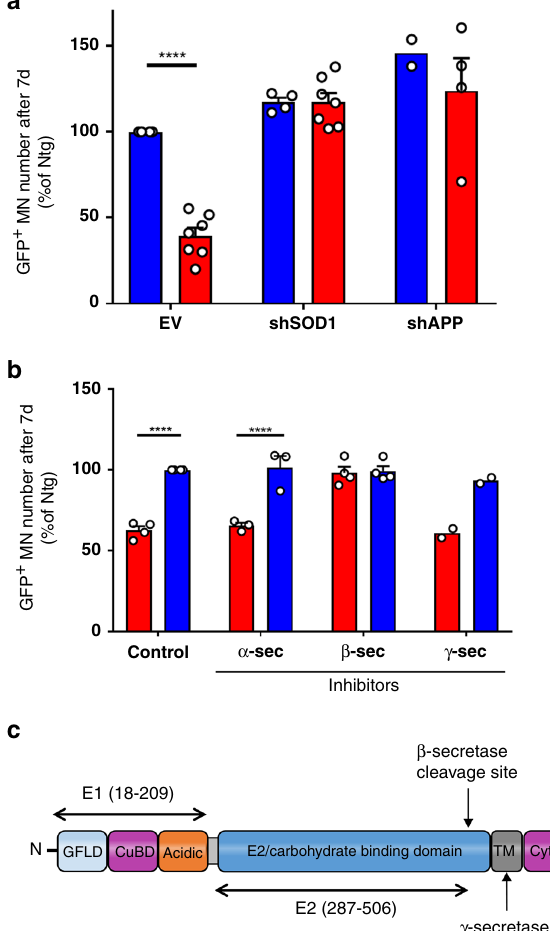
Fig. 3 mutSOD1 astrocytes release β -secretase sensitive N-APP fragments that cause toxicity in ALS in vitro models. a NTg (blue) or mutSOD1 (red) astrocytes infected with empty vector (EV) ( n = 4 NTg and n = 7 mutSOD1), sh-SOD1 ( n = 4 NTg and n = 7 mutSOD1) or sh- APP ( n = 2 NTg and n = 4 mutSOD1) selected with puromycin for 4.5 days, replaced with regular astrocyte media and then were co- cultured with mouse ES-MNs expressing EGFP under the control of the MN-speci fi c Hb9 promoter. Viability was measured at 7 DIV. MNs were counted using Metamorph software. Data for EV and sh-SOD1 are means ± SEM of independent experiments ( n ) and were analyzed by a two-way ANOVA (Interaction F (2,22) = 7.824; P = 0.0027) followed by a Sidak post hoc test: **** P ≤ 0.0001 EV NTg vs mutSOD1 (CI: 32.34 – 88.86%; d = 7.29). Data for sh-APP in NTg ( n = 2) are means only and were not analyzed by statistics. b Inhibitors of α -secretase ( n = 3), β -secretase ( n = 4), γ -secretase ( n = 2), or vehicle control ( n = 4) were applied twice (1 DIV and 4 DIV) at 5 μ M, 250 nM, and 500 nM, respectively to primary MN and GFP + MNs were counted on DIV 7.